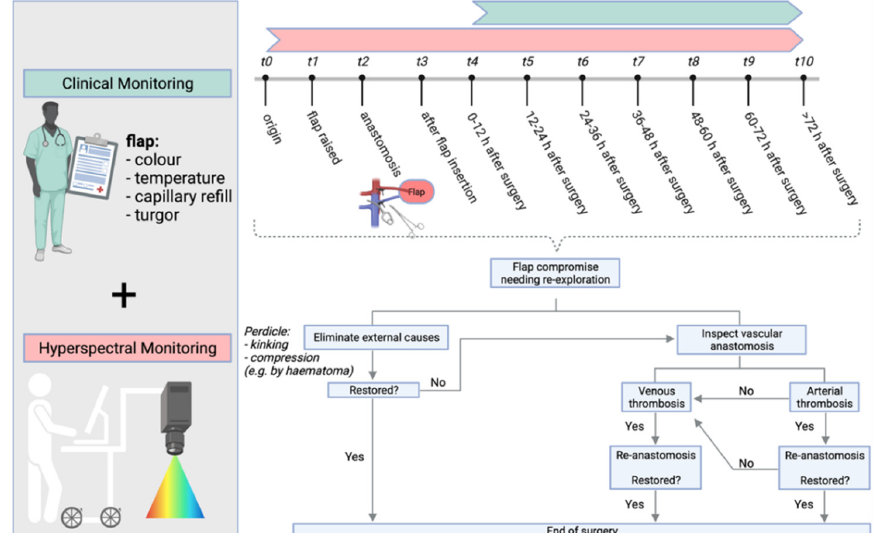
Figure 1. Graphical study protocol shows the measurement time points (t0–t3) and time intervals (t4– t10), as well as the process of decision making for re-exploration surgery. Created with BioRender.com (accessed on 13 October 2021). Table 1. Clinical flap evaluation system with point